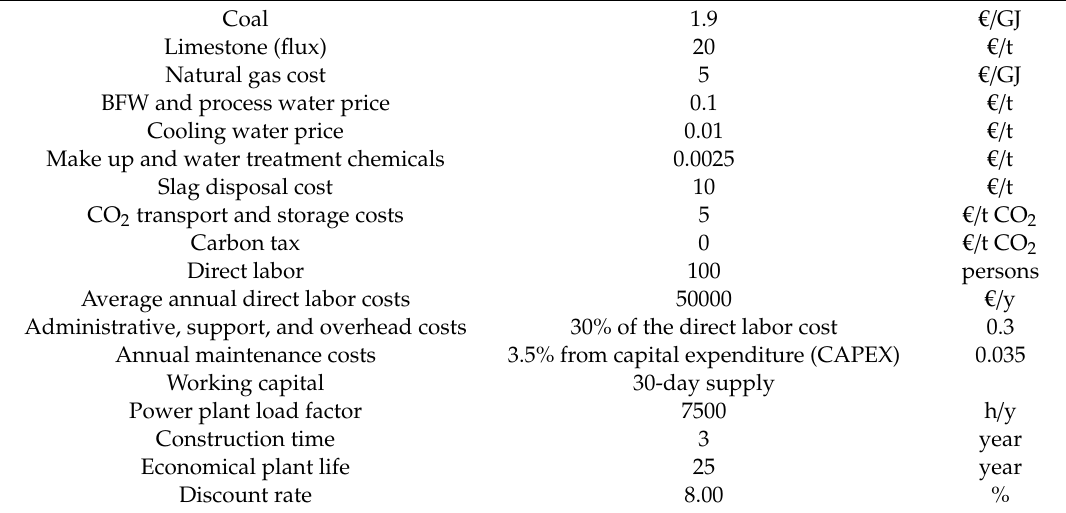
Table 4. Basic economic assumptions for calculation of operation and maintenance (O&M)